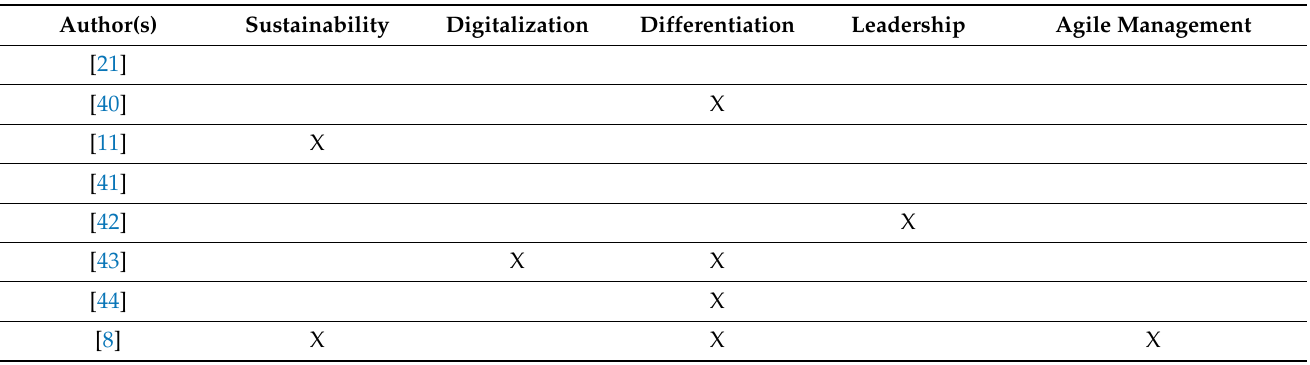
Table 6 lists the sub-categories under the organizational category, in which the sub- Table 6. Sub-categories for